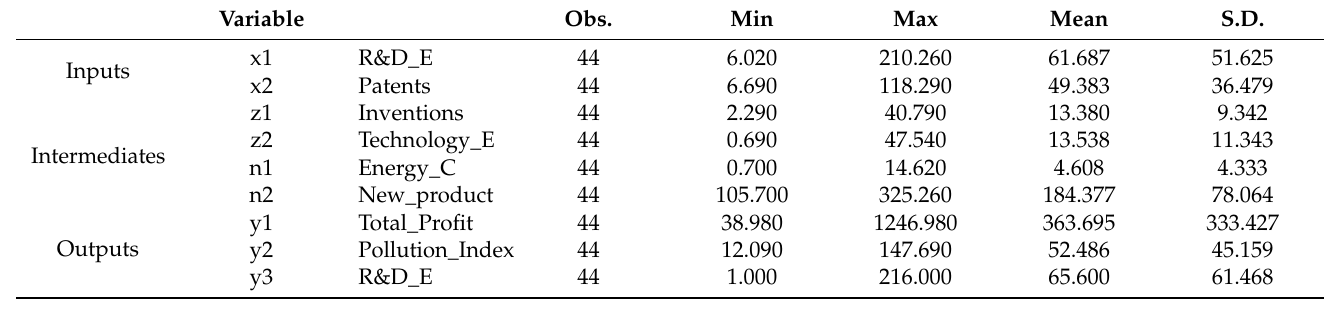
Table 3. Descriptive Statistics of the Variables for Efficiency Measurement.